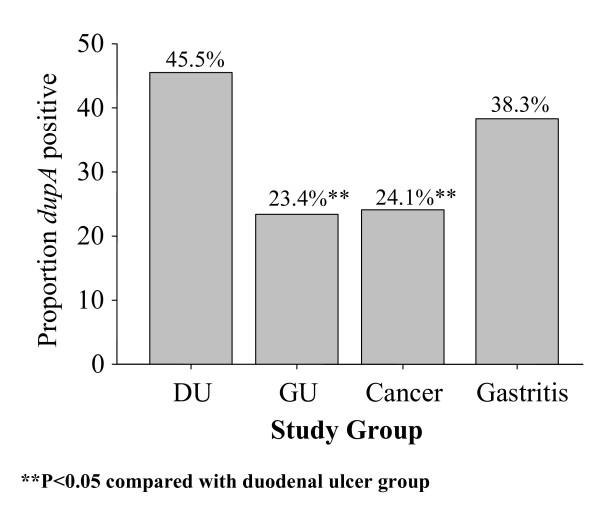
Prevalence of the dupA gene and clinical outcomes.